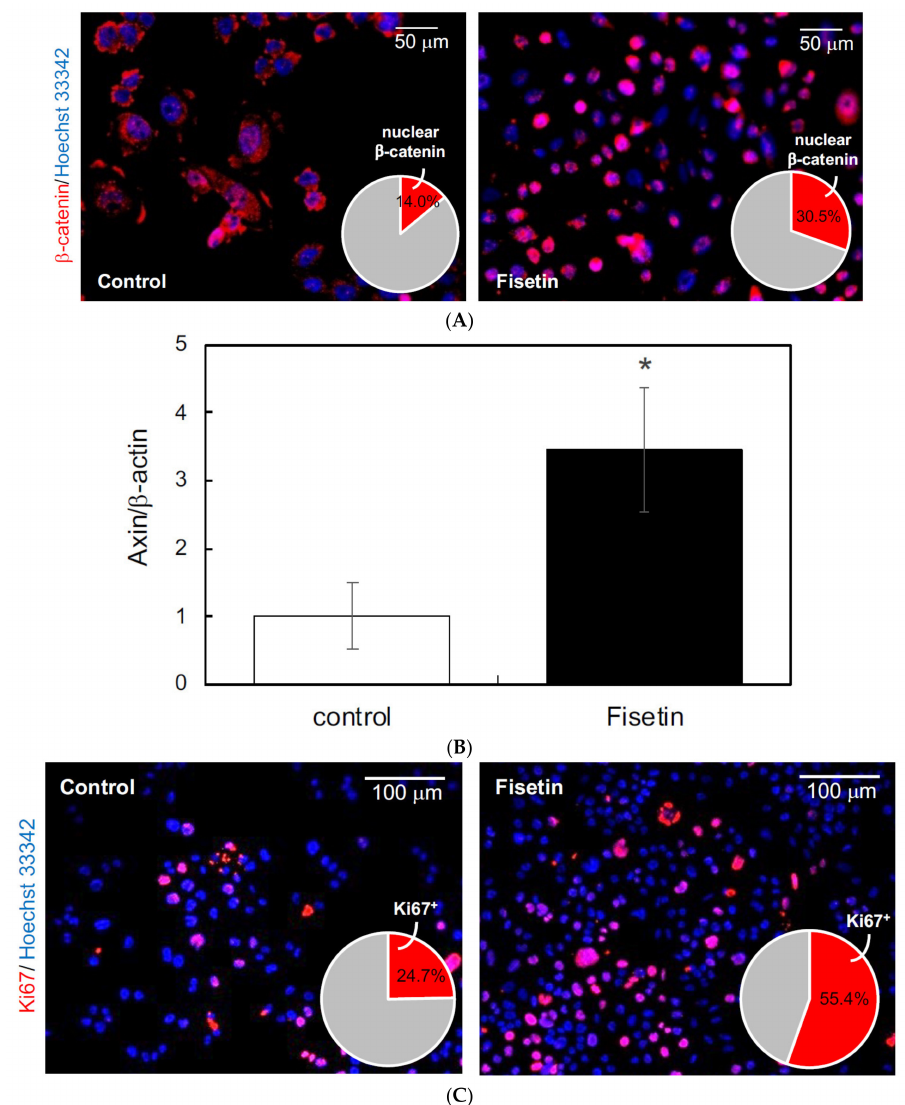
Figure 4. Effects of exosomes derived from fisetin-treated keratinocytes on hair follicle stem cells (HFSCs). ( A ) Localization of β -catenin in HFSCs was evaluated by immunocytochemistry using anti- β -catenin antibody. Nuclear localization of β -catenin (red in pie chart) in HFSCs treated with exosomes was quantitatively determined using IN Cell Analyzer 2200. ( B ) Expression of axin in HFSCs treated with exosomes was quantitatively determined using qRT-PCR. ( C ) Ki67 + cells in HFSCs were detected by immunocytochemistry using anti-Ki67 antibody. The number of Ki67 + cells (red in pie chart) was determined using IN Cell Analyzer 2200. Statistical significance was determined using a two-sided Student’s t-test. Statistical significance was defined as p < 0.05 (* p <